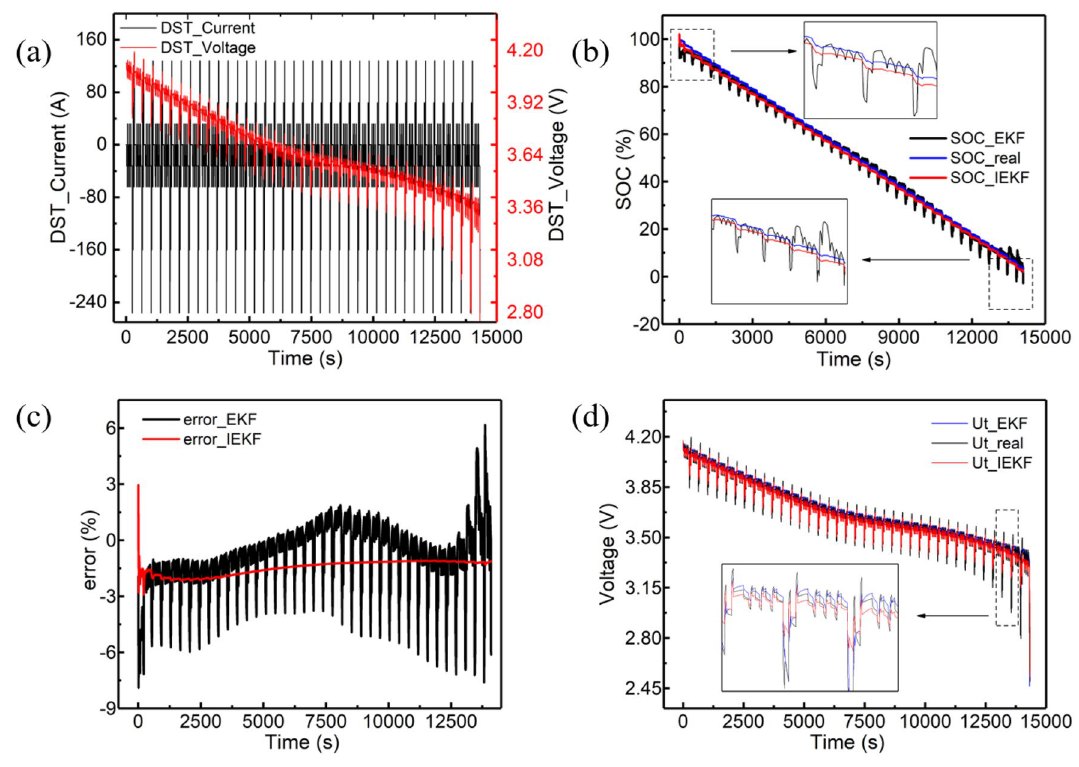
Figure 6. Results of IEKF and EKF under DST condition: (a) testing condition; (b) results compared with EKF; (c) error analysis; (d) The esimated voltage result profile.